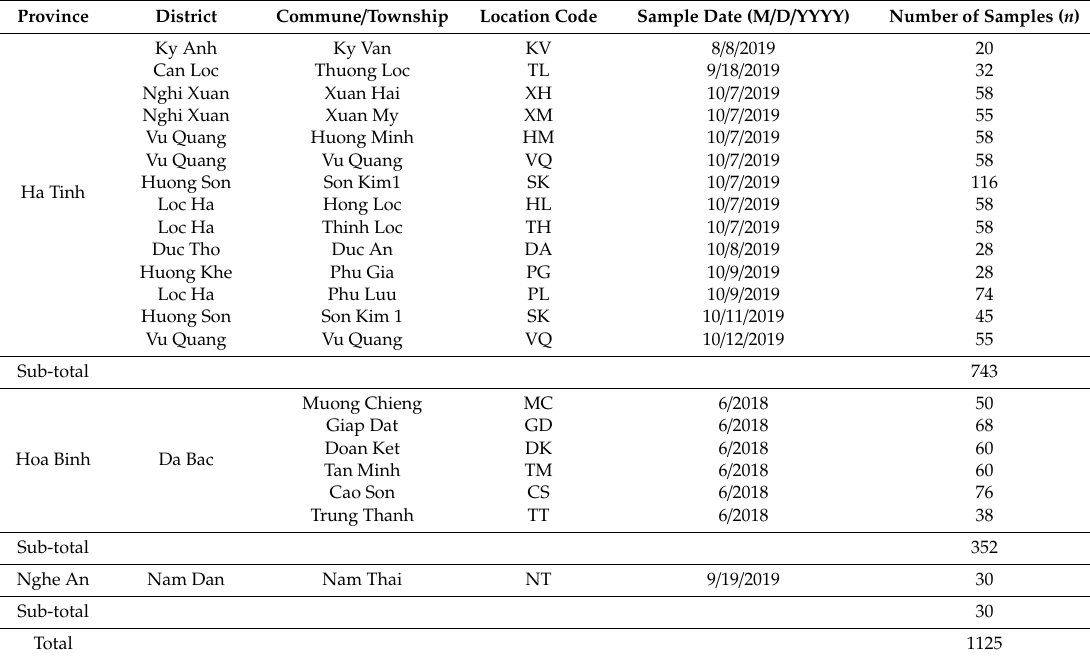
Table 1. Swine sample